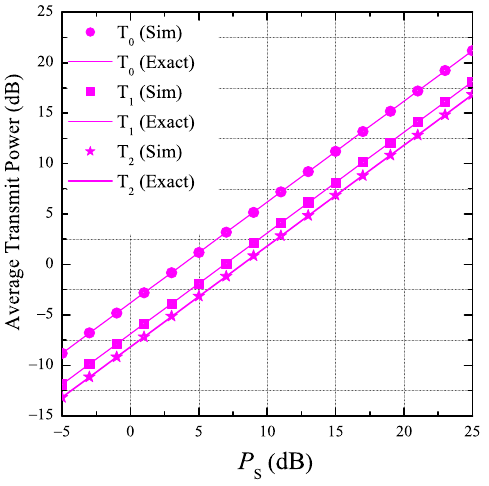
Figure 2. Average transmit power of the secondary transmitters as a function of P S when K = 3, N D = 3, ε = 0.25, η = 0.25, x B = 0.4, y B = 0.3, x P = 0.6, and y P = −